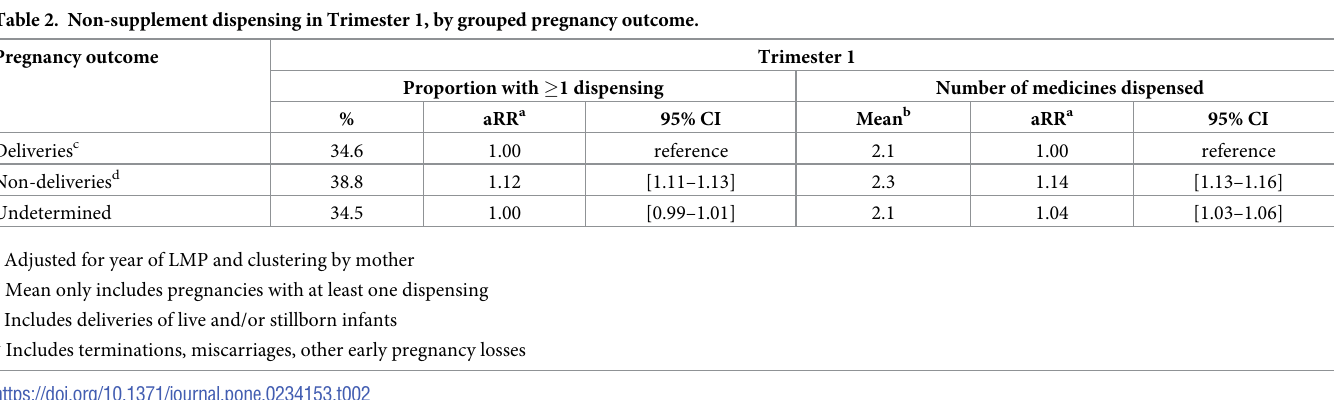
(Table 4). The relative risks for associations with maternal characteristics found in the com- plete case analyses were broadly similar to those reported above (S8 Table). Therapeutic groups dispensed during at least 1% of pregnancies are shown in Table 5 (rela- tive risks and 95% confidence intervals for trends during pregnancy and for trends over time are available in S9 and S10 Tables respectively). All therapeutic groups dispensed to at least one cohort member before or during pregnancy are listed in S11 Table. Overall, Minerals (36.9%) and Antianaemics (27.8%) were dispensed in the highest proportion of pregnancies. Practically all of the pre-pregnancy and pregnancy Antianaemics dispensings were folic acid. Antibacterials (26.0%), Analgesics (16.7%) and Antinausea & Vertigo Agents (11.0%) were the